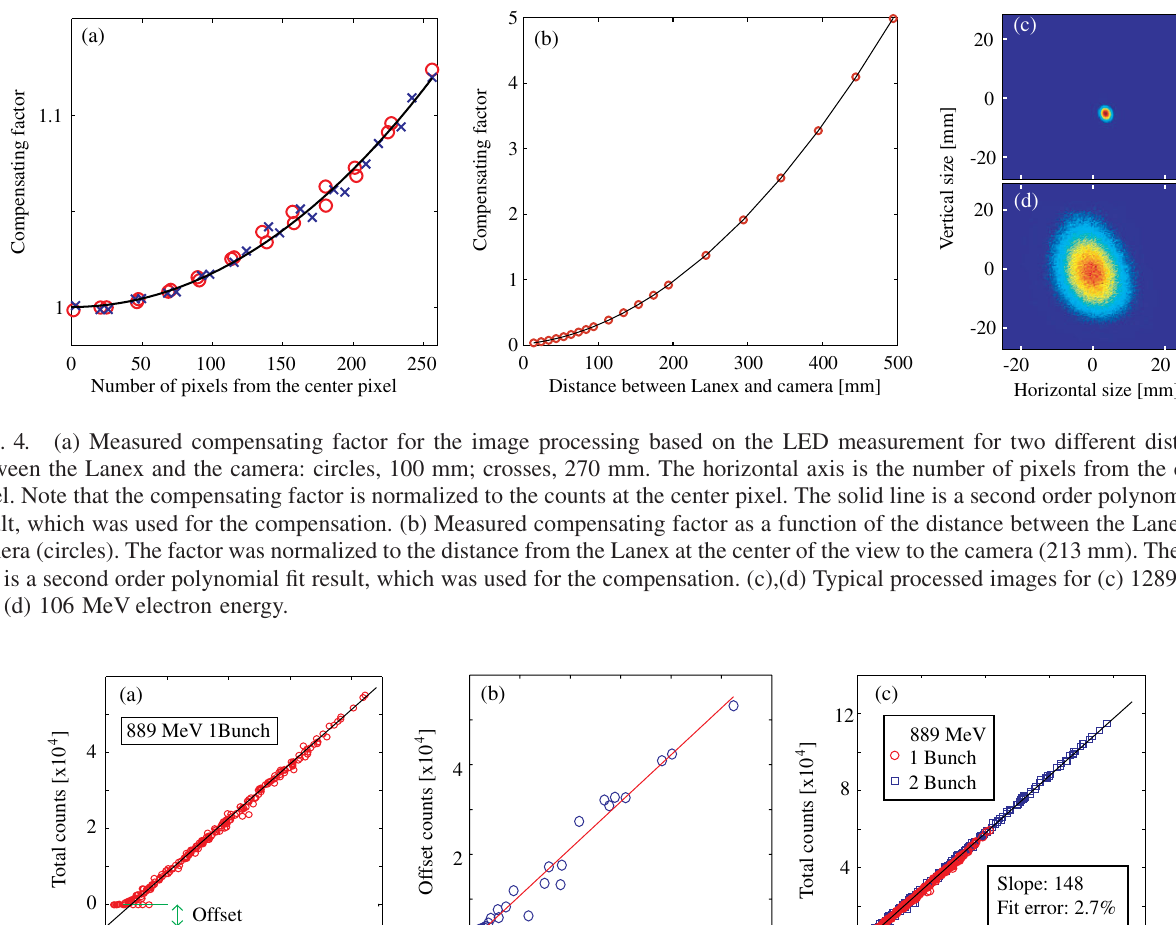
Slope: 148 Fit error: 2.7%